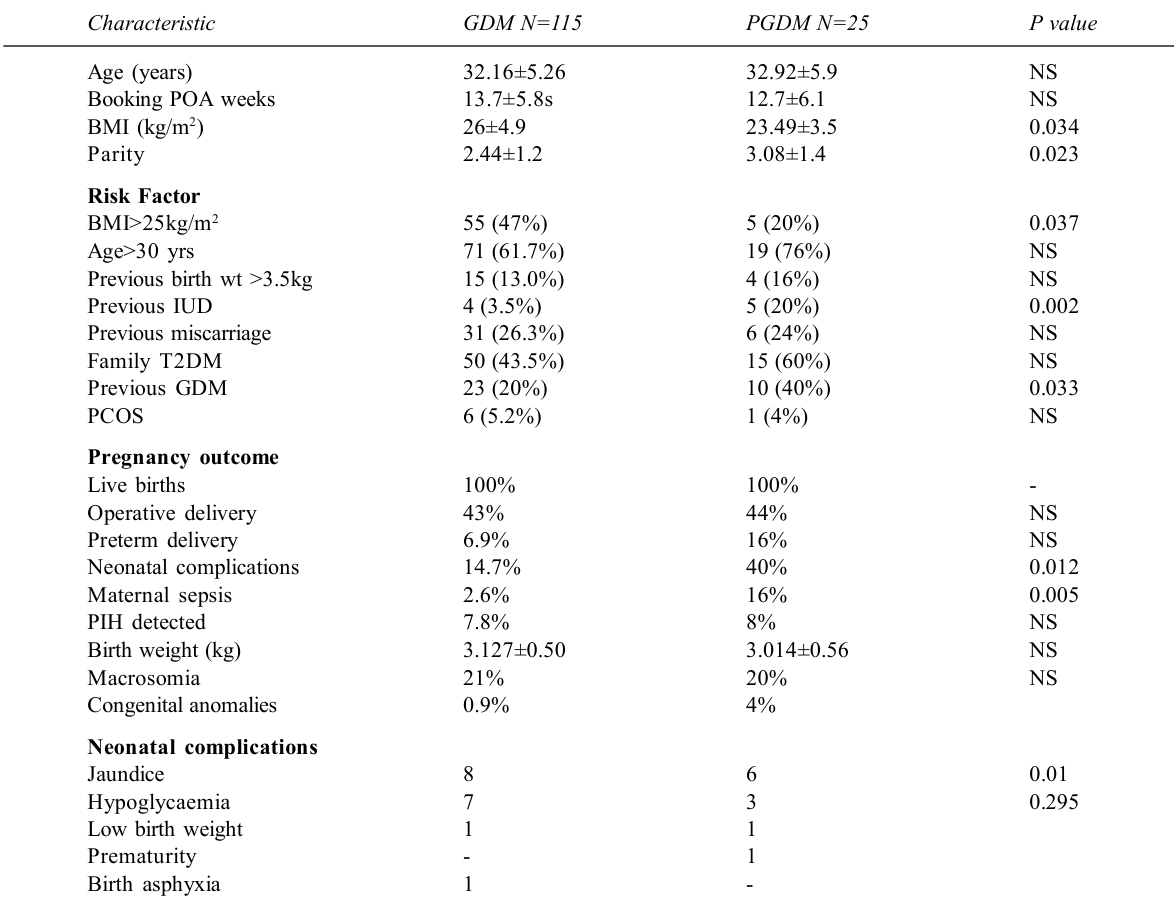
Table 1. Comparison demographic data, risk factors, pregnancy outcome and neonatal complications of gestational versus pre-gestational diabetes